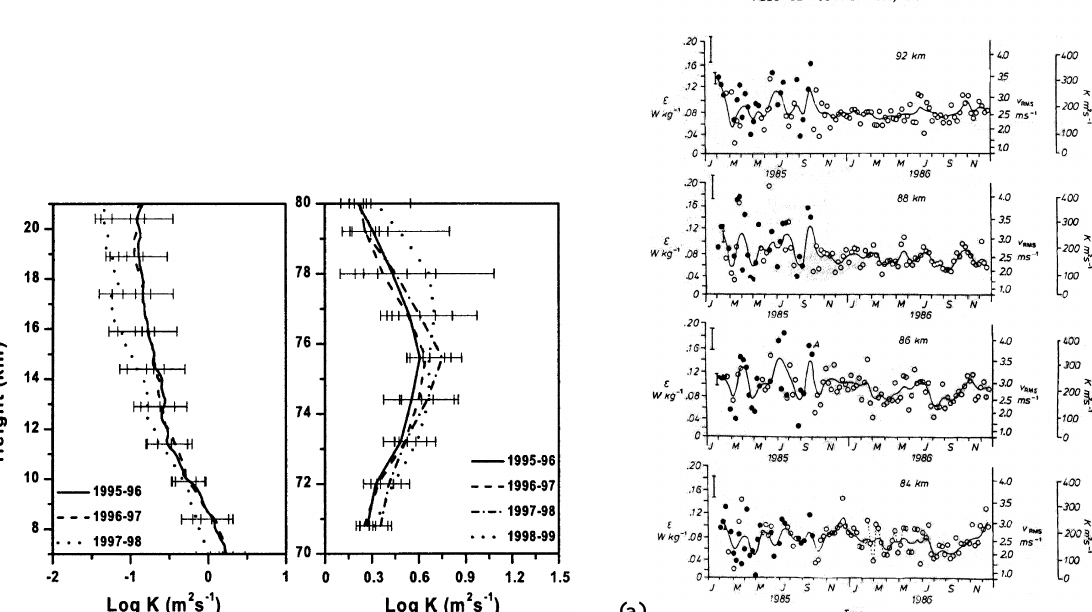
Fig. 7. (a) : Annual medians of K (m 2 /s) inferred from the Indian MST radar (Rao et al., 2001). (b) : One week average of TKE dissipation rates (left axis), rms velocities and turbulent diffusivities (right axis), as a function of time for altitude 84, 86, 88 and 92km, during two